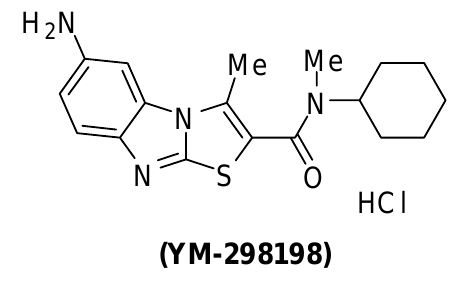
Figure 4. Chemical structure of